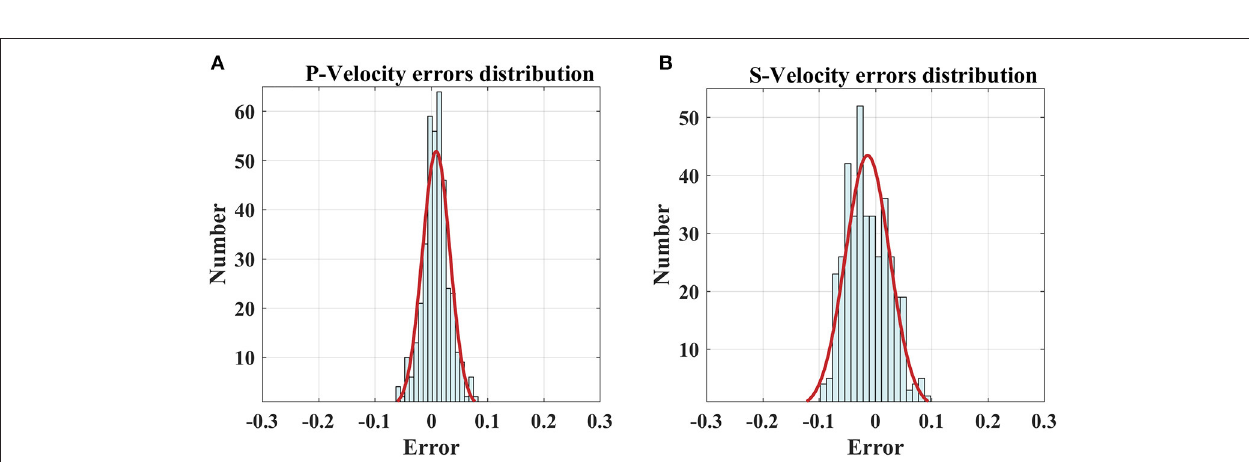
FIGURE 4 | The comparison of the estimated (in red) and the actual (in blue) P-wave and S-wave velocity of the actual well L2. (A) Lithology information (the mud-rich source rock in gray and sandstones in yellow) and mud content, (B) Lithology information and TOC content, (C) P-wave velocity, (D) S-wave velocity.